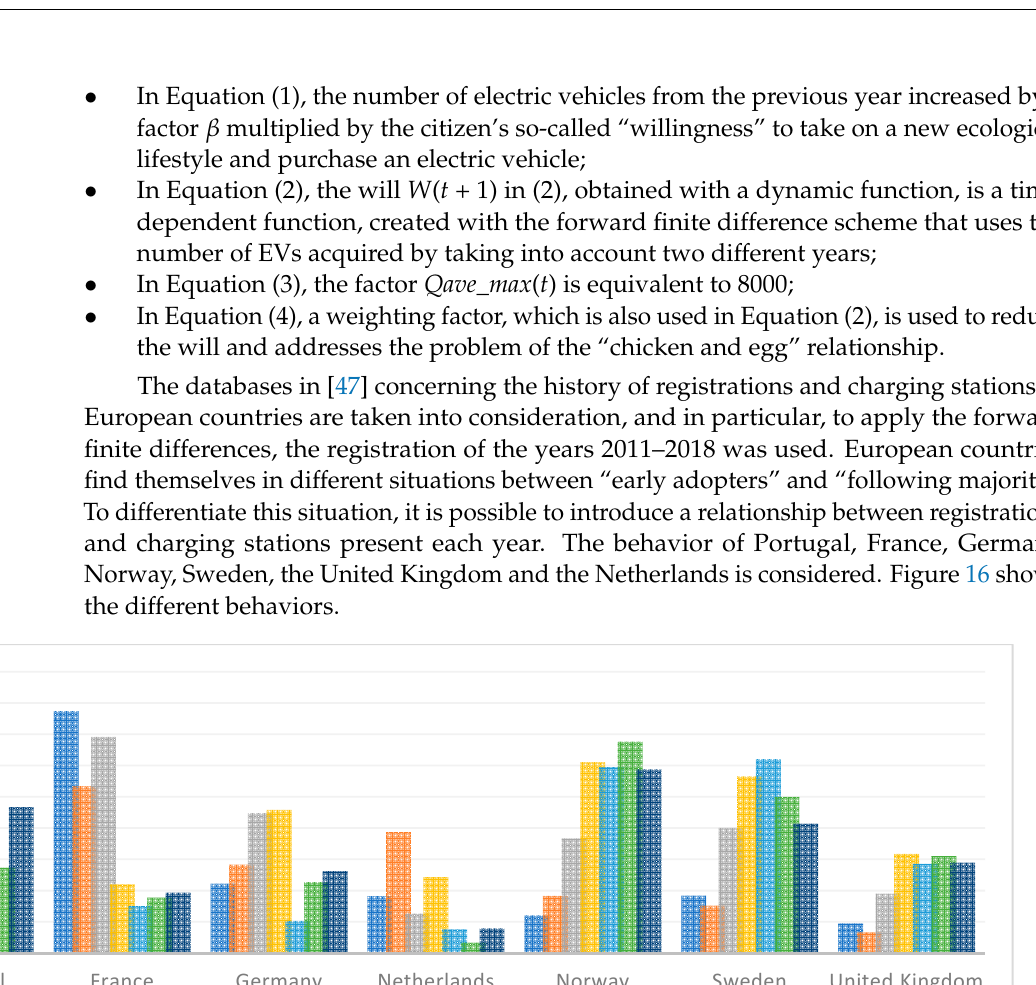
0.001.002.003.004.005.006.007.008.009.00 Figure 16. Ratios of new registrations and active charging stations. Figure 16. Ratios of new registrations and active charging Figure 17. Ability to increase FC charging stations in Portugal, numerical evaluation (blue) and trend (orange). Initially, the number of enabling FCs is considered weighed on the basis of the number of electric charging stations present. If a number of FC charging stations equal to the electric one divided by a factor of 25 are inserted in a year zero, this number can be increased in a sequence of subsequent years based on the reaction to innovation. By inserting the data from Portugal in the SERA model, it is possible to see that in five years, the FC charging stations will increase by a factor between 4 and 5. In Figure 17, the trend in blue represents the discrete values obtained by the SERA model, while orange represents the trend line. These predictions have been made from the inclinations of electric vehicle users [49]. In conclusion, it can be said that the implementation of new mobility solutions based on sustainable vehicles, such as electric, hybrid or hydrogen cars in urban transport systems, can bring several benefits for society, from environmental and economic benefits to improving the quality of life. However, people may be discouraged from using new transport technologies due to a lack of knowledge. Therefore, an aspect to be taken into consideration and which is still not receiving much attention, concerns education that